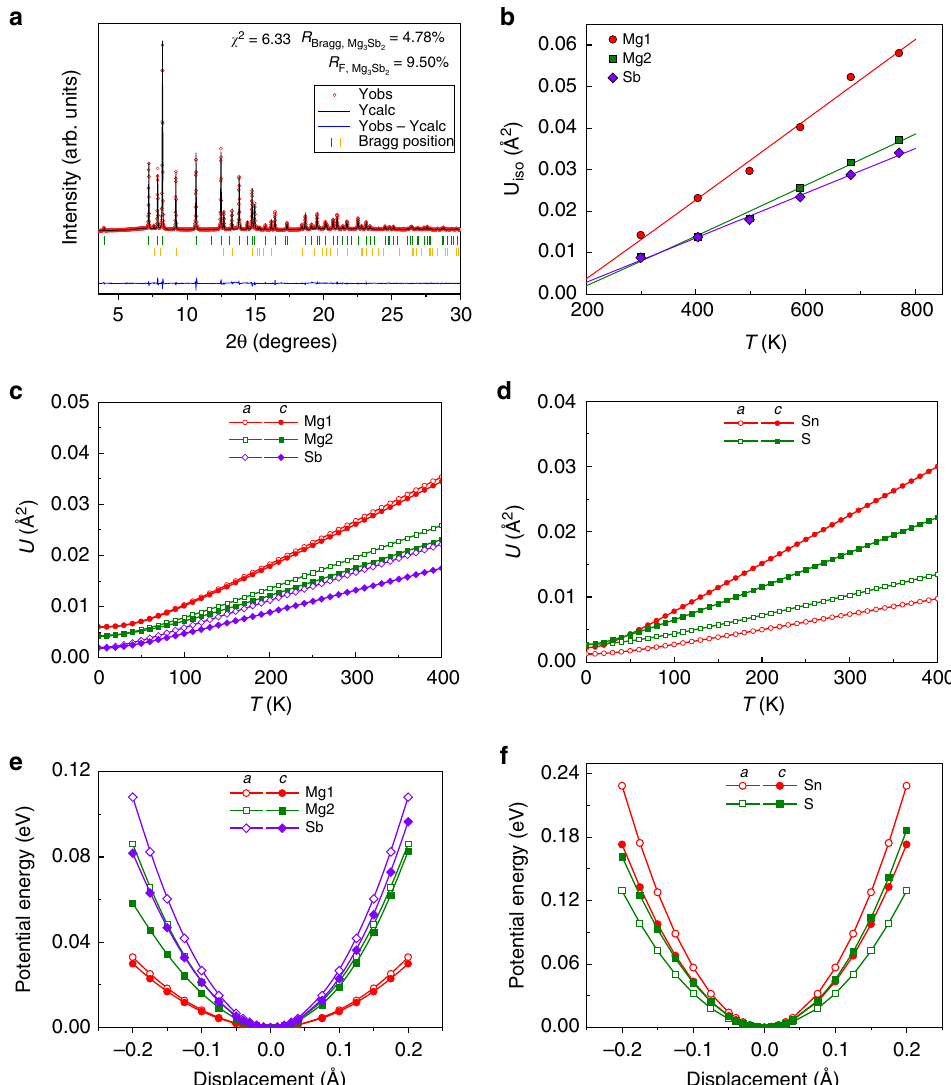
Fig. 4 Atomic displacement parameters and potential energy curves. a Calculated (Rietveld method) and observed synchrotron PXRD patterns of Mg 3 Sb 2 at 770 K upon cooling. Red open circles and black line are observed and calculated data, respectively. The blue line represents the difference between the observed and calculated patterns. The green and orange vertical bars correspond to the Bragg positions of the main phase Mg 3 Sb 2 and the secondary phase Sb, respectively. b Temperature dependence of the experimental isotropic atomic displacement parameters of Mg 3 Sb 2 . c , d Temperature dependence of the theoretical atomic displacement parameters along different axial directions of ( c ) Mg 3 Sb 2 and ( d ) SnS 2 . e , f The potential energy curves for the nonequivalent atoms of ( e ) Mg 3 Sb 2 and ( f ) SnS 2 as a function of the displacements from the equilibrium